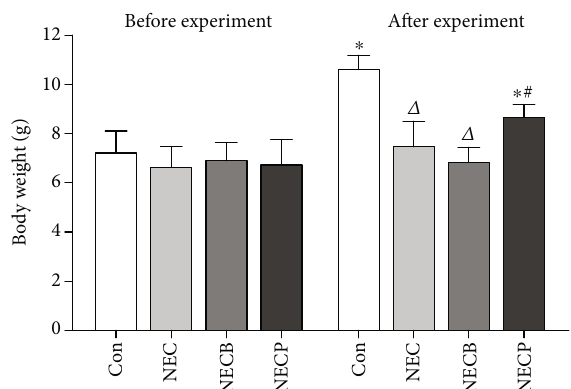
Figure 1: Inhibition of A R by PSB1115 protected NEC rats 2B against the loss of body weight. No signi fi cant di ff erences in body weight were observed between groups before experiment. NEC results in marked body weight loss after experiment as compared to the control group. However, PSB1115 protects NEC animals against body weight loss. NEC: necrotizing enterocolitis; NECB: necrotizing enterocolitis+BAY60-6583 treatment; NECP: necrotizing enterocolitis+PSB1115 treatment. Δ p < 0 : 05 vs. all other groups; ∗ p < 0 : 001 vs. baseline (before experiment); # p < 0 : 001 vs. the Con